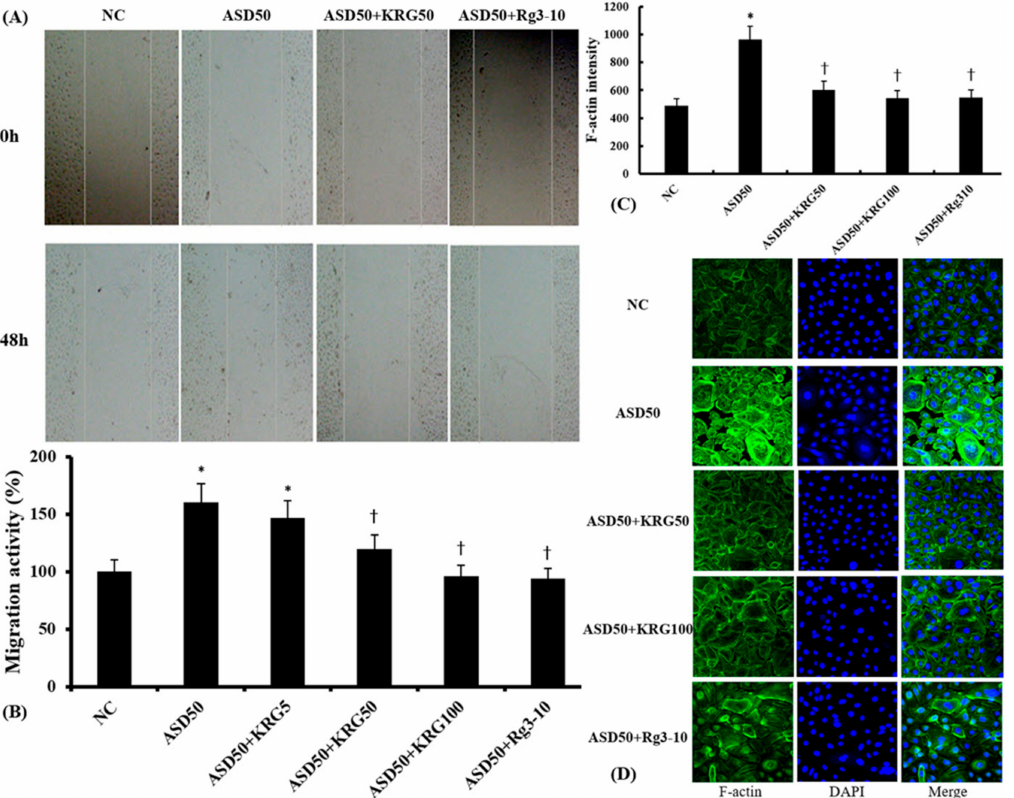
Figure 5. Effects of Korean red ginseng (KRG) and ginsenoside Rg3 on the migration ability and F-actin expression of Asian sand dust (ASD)-stimulated nasal epithelial cells measured using the cell migration assay and immunofluorescence study. ( A ) shows representative images of the cell migration scratch assay. KRG (50 and 100 µ g/mL) and Rg3 (10 µ g/mL) significantly inhibited ASD-induced cell migration ( B ) and F-actin expression ( C ). ( D ) shows the representative fluorescein immunofluorescence images of F-actin. NC: negative control (NC means nasal epithelial cells were not treated with ASD, KRG, or Rg3). *: p < 0.05 compared with NC. †: p < 0.05 compared with ASD-stimulated group, n =